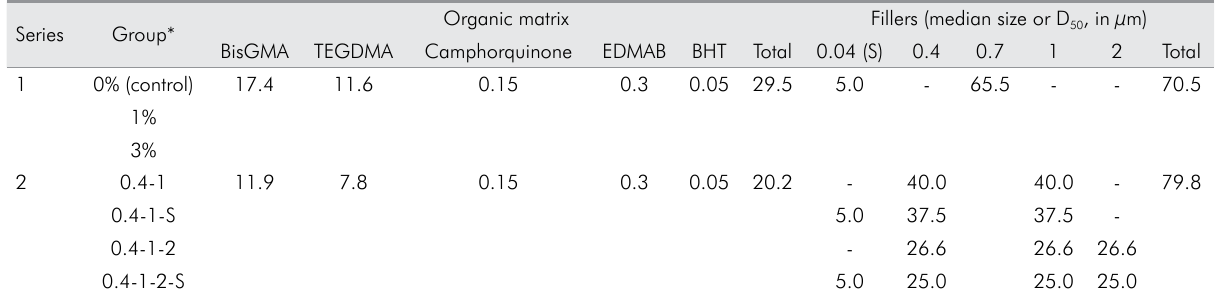
Table 1. Mass fractions (in weight) of the experimental composites tested (Series 1: silane content; Series 2: particle size distribution). Organic Series Group*